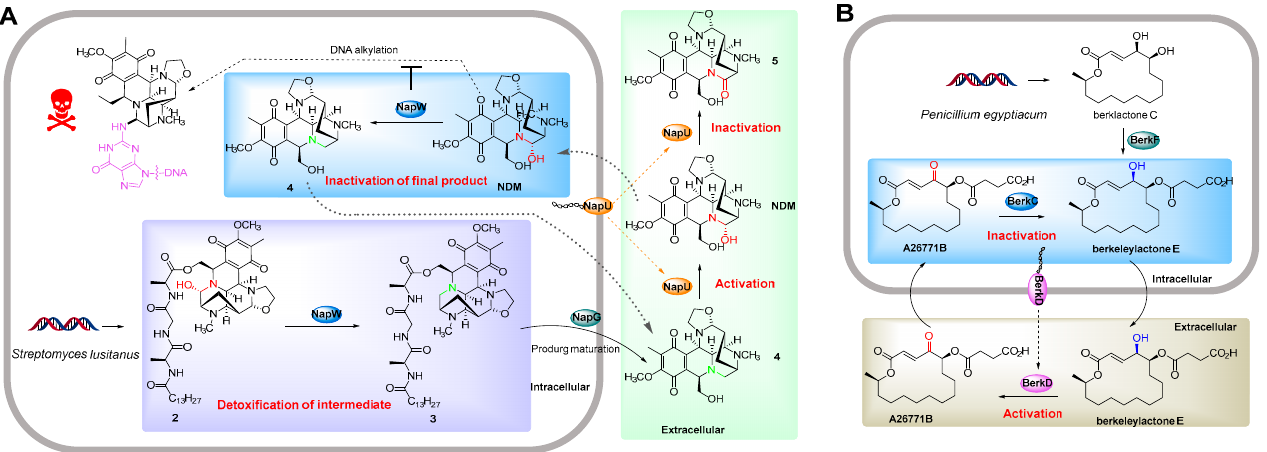
Figure 2. Examples of temporal-spatial shielding resistance model. ( A ) Self-resistance mechanisms of NDM producer Streptomyces lusitanus. Cytosol-located short-chain dehydrogenase/reductase NapW confers temporal shielding of NDM cytotoxicity by detoxification of biosynthetic intermediate and inactivation of re-entered final product. The membrane protease NapG couples with the secreted oxidoreductase NapU contributes to spatial shielding of NDM activity by prodrug maturation, NDM activation and inactivation. ( B ) Self-resistance mechanisms of A26771B producer Penicillium turbatum. Activation of the final product A26771B in extracellular space by the secreted oxidoreductase BerkD ensures the safety of producer via spatial shielding. Intracellular A26771B inactivation by cytoplasmic short-chain reductase BerkC and the subsequent recycling of the products control the self-harm of its producer from time.